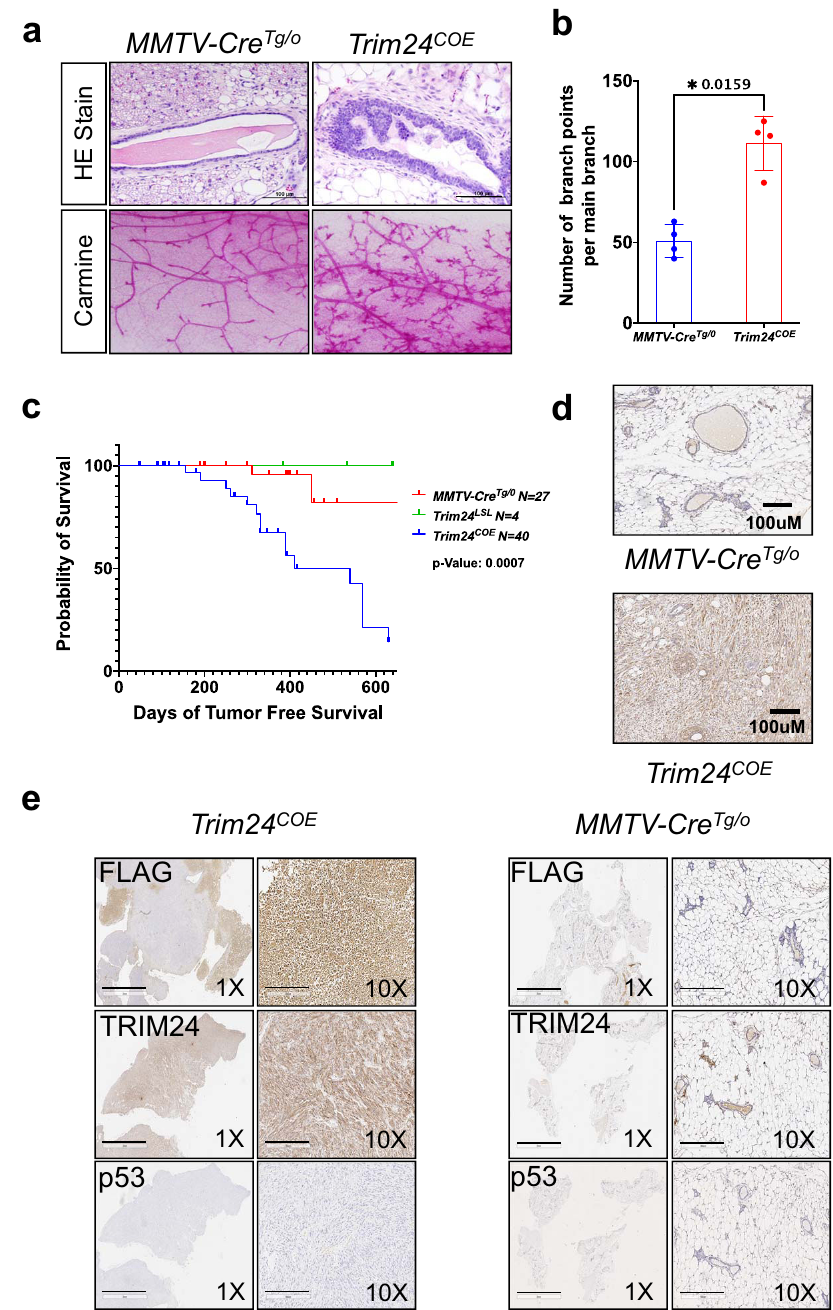
Fig. 1 TRIM24 over-expression promotes hyperplasia, increases ductal branching, and tumorigenesis. a Top panels show H&E staining and bottom panels carmine alum staining of mammary glands of 2-month-old Trim24 COE and control MMTV-Cre Tg/0 . b Quanti fi ed comparison of mammary gland branch points per ductal main branch of 2-month old ( n = 4 mice each) MMTV-Cre Tg/0 (blue) and Trim24 COE (red) mice. Data represented as mean with SD and p -value (*<0.05) is calculated using two-tailed paired t test. c Tumor-free percent survival curve of MMTV-Cre Tg/0 , Trim24 LSL , and, Trim24